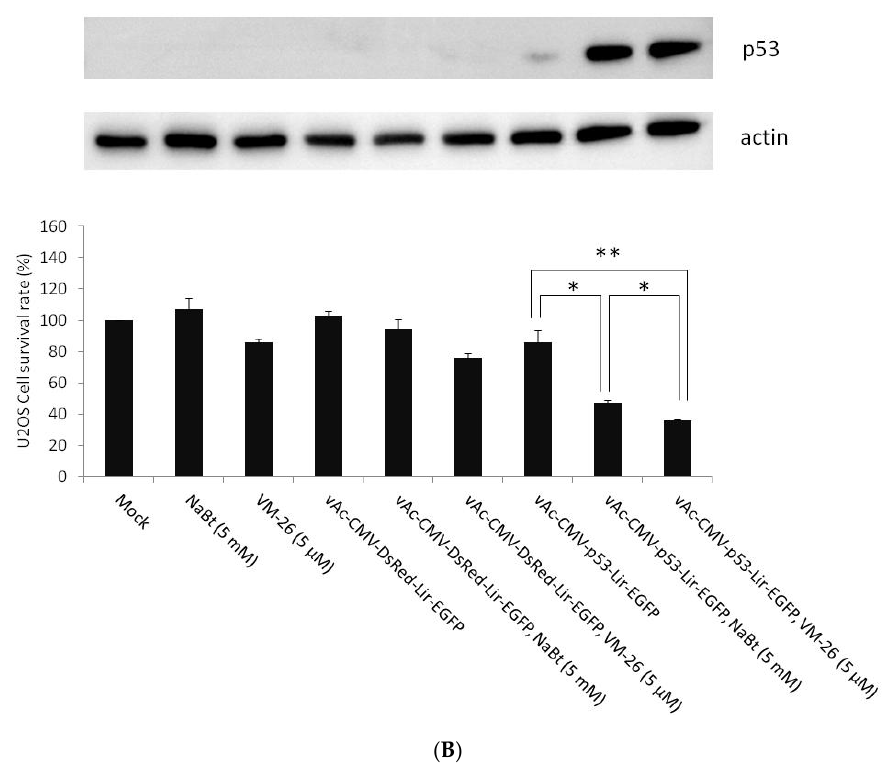
Figure 5. VM-26 enhances the BacMam-mediated p53 gene therapy effect in U-2OS cells. ( A ) Representative images of mock transduction, vAc-CMV-DsRed-Lir- EGFP (moi = 100), or vAc-CMV- p53-Lir- EGFP (moi = 100) transduced U-2OS cells (5 × 10 4 cells seeded in a 24-well plate) that were concomitantly treatment with NaBt or VM-26 for 24 h. Pictures were taken 24 h after transduction under bright field or a FITC channel with a 450/490-nm filter set using an exposure time of 1 s; scale bar is 50 μm; ( B ) The cell viability of ( A ) was determined by MTT assay as described in the Materials and Methods. The upper panel displays the Western blot analysis of p53 proteins in the cell lysates of ( A ) probed with an anti-p53 antibody. Actin was used as a loading control. * p < 0.05 when compared with the corresponding control groups; ** p < 0.005 when compared with the corresponding control groups.